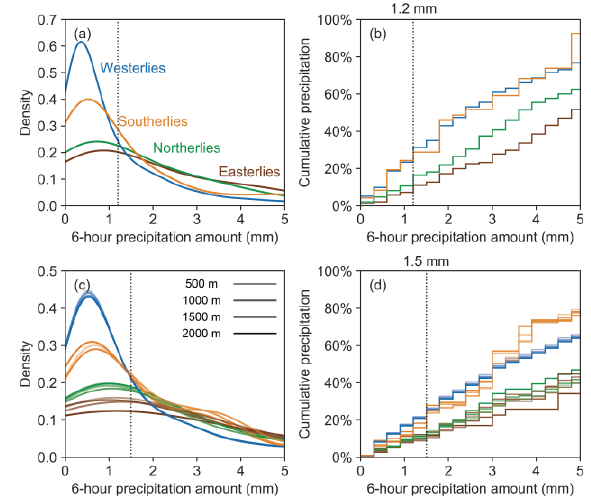
Figure 8. Kernel density estimation plots for 6 h cumulative precipitation data (a and c) and amount-weighted cumulative 6 h precipitation histogram (with a bin size of 0.3 mm) (b and d) related to different trajectory clusters. Results are separated for the GDAS (a and b) and the NCEP/NCAR (c and d) reanalysis datasets. The color coding follows Figure 6. The transparency of lines in (c and d) is coded to represent results derived from different initial back-trajectory heights. The results derived from an initial back-trajectory height of 2000 m agl have zero transparency. The transparency increases (showing lighter color) with a decreasing initial back-trajectory height from 1500 m to 500 m agl. Distal westerlies have much higher frequency of precipitation amount less than 1.2 mm (for the GDAS) and 1.5 mm (for the NCEP/NCAR) in 6 h than distal easterlies marked by vertical dotted lines.